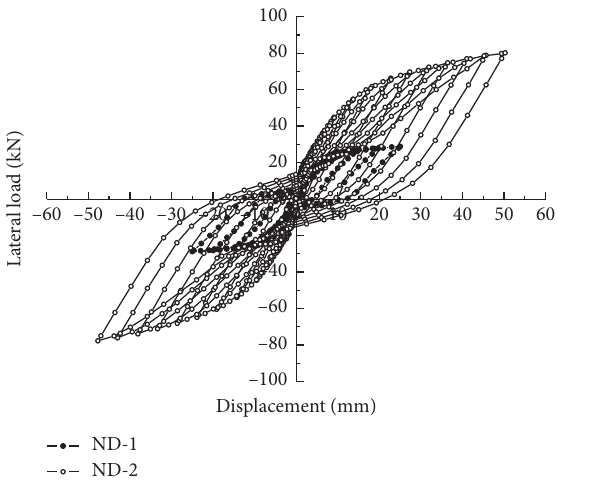
Figure 8: Hysteretic curves. Figure 9: Skeleton